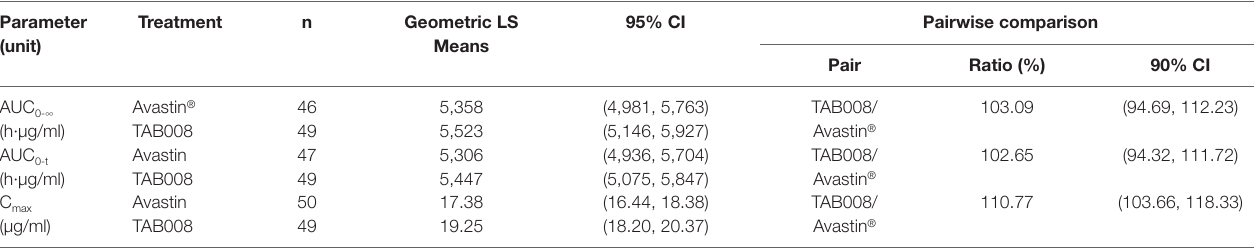
TABLE 2 | Statistical comparison of primary pharmacokinetic parameters. Parameter